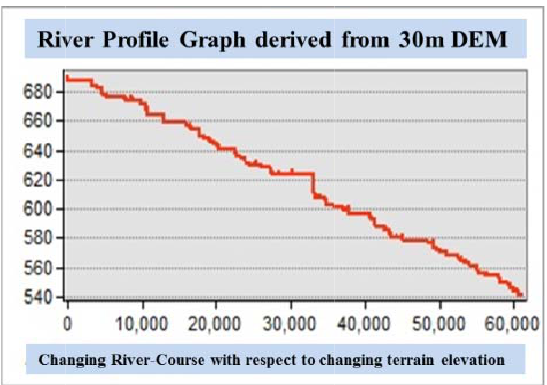
e 6c. Showing Ri